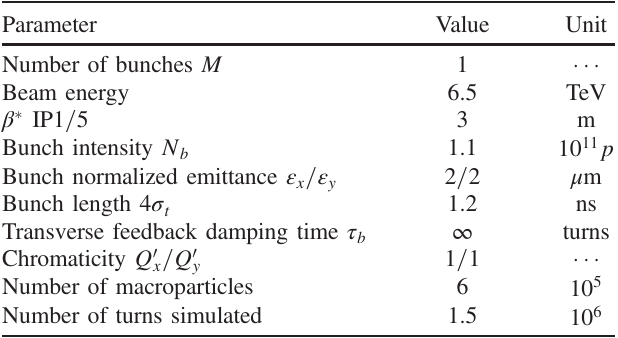
TABLE II. Bunch and machine parameters used for the P Y HEADTAIL simulations. The values used were to reduce the level of complexity of the simulations.